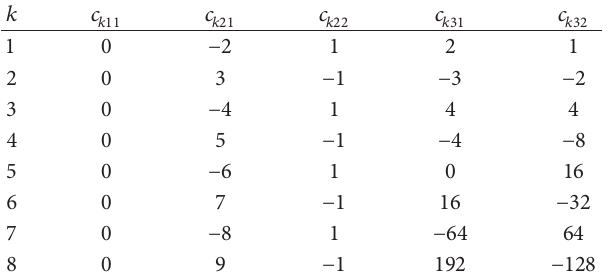
Table 2: The residues of 𝑟 𝑘 (𝑠) , 𝑐𝑘 𝑖𝑗 in Example 4. Table 3: The residual polynomial coefficients of 𝑟 𝑘 (𝑠) , 𝑒 𝑘ℎ in Example